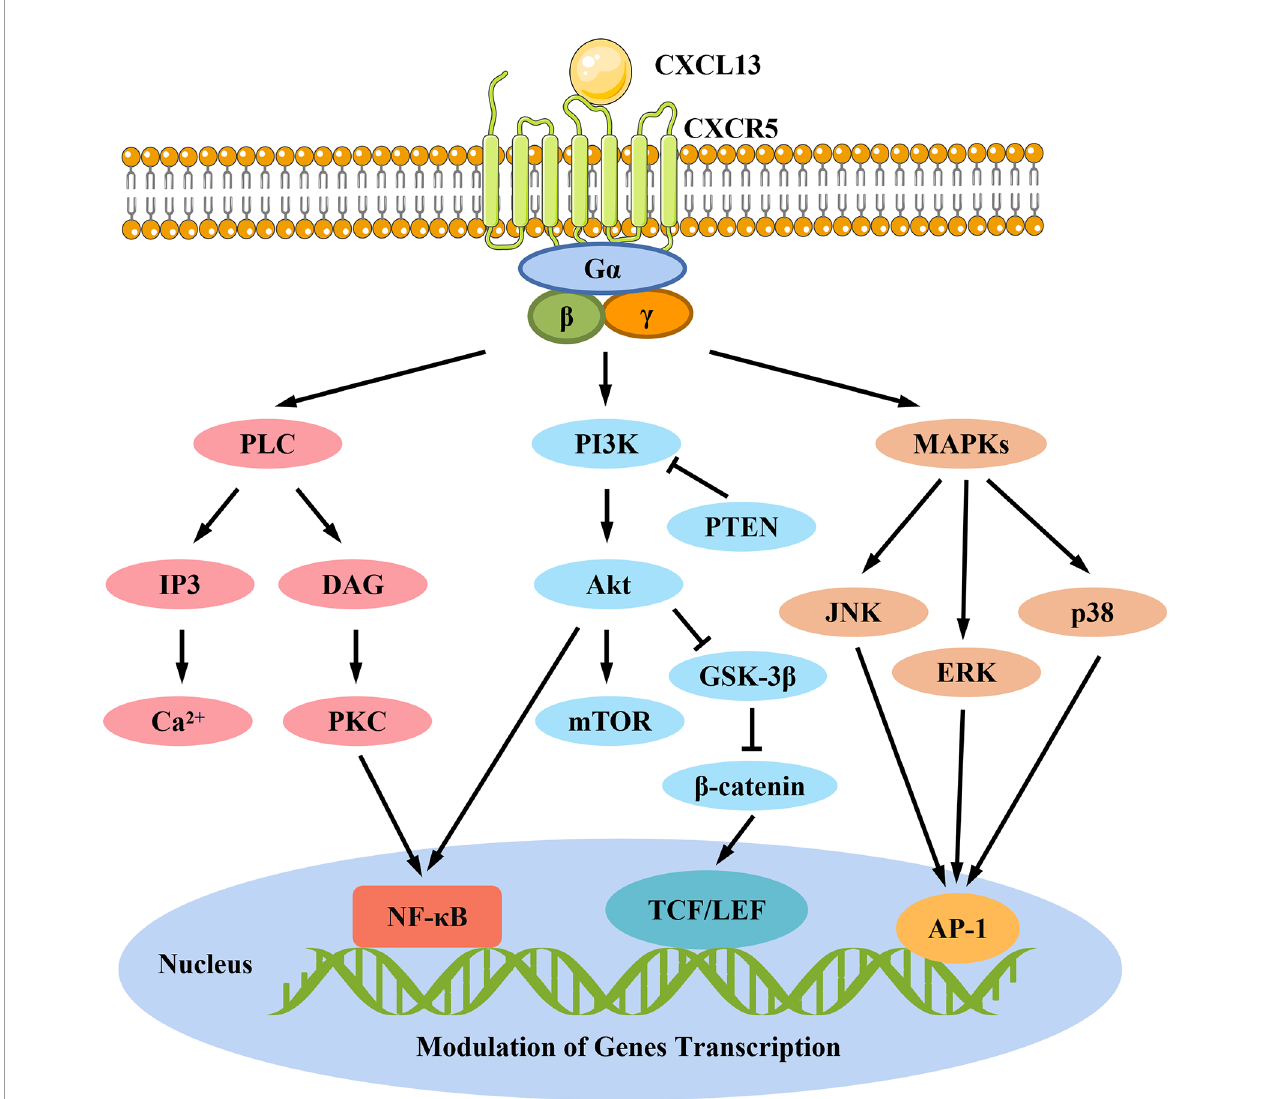
FIGURE 4 | CXCL13/CXCR5-mediated signaling pathways. CXCL13 exerts its biological functions through activating CXCR5, a chemokine receptor coupled to G- protein heterotrimer. Upon activation, CXCR5 undergoes conformation change and induces the cycle of G-protein activation, leading to a cascade of downstream signal transduction pathways including: (1) activation of PLC leads to conversion of PIP2 to IP3 and DAG. IP3 can promote the release of Ca 2+ from intracellular stores into the cytoplasm. On the other hand, DAG consistent with increased Ca 2+ activate PKC, which contributes to the activation of transcription factor NF- k B to promote cell migration; (2) activation of PI3K can trigger the activation of Akt, thus stimulating downstream NF- k B, mTOR, and GSK-3 b / b -catenin/TCF/LEF signaling, which play key roles in tumor cell growth, proliferation, invasion, and migration; (3) CXCR5 also activates MAPK pathways utilizing JNK, ERK, and p38 via G-protein, which may further stimulate AP-1 to promote cell proliferation and in fl ammation. AP-1, activating protein-1; DAG, diacylglicerol; ERK, extracellular signal-regulated kinase; GSK-3 b , glycogen synthase kinase-3 b ; IP3, inositol triphosphate; JNK, c-Jun N-terminal kinase; mTOR, mammalian target of rapamycin; NF- k B, nuclear factor- k B; PI3K, phosphoinositide 3-kinase; PKC, protein kinase C, PLC, phospholipase C; PTEN, phosphatase and tensin homologue; TCF/LEF, T-cell factor/ lymphoid enhancer-binding